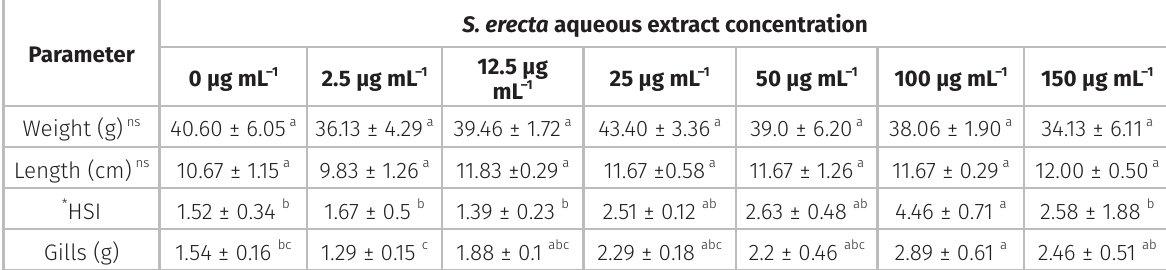
Table III. Morphometric parameters of liver and gills of Piaractus mesopotamicus (n=5) exposed to different concentrations of Serjania erecta aqueous extract for 4